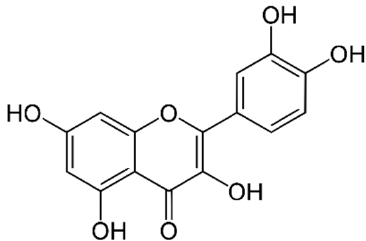
Figure 1. The chemical structure of quercetin.